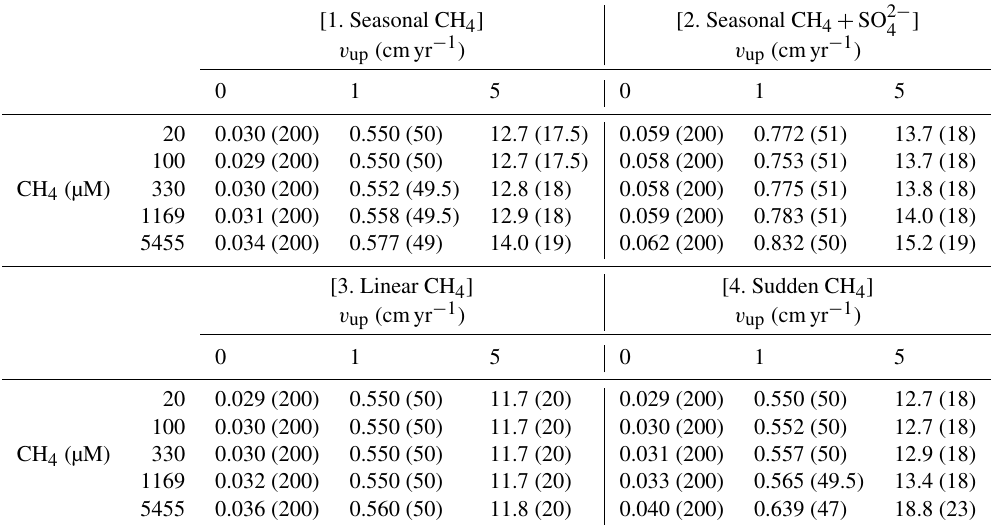
Table 3. Maximum of methane fluxes (in µmolcm − 2 yr − 1 ) at SWI for the four analysed transient scenarios. Values in round parenthesis indicate the year after the beginning of simulation corresponding to the reported